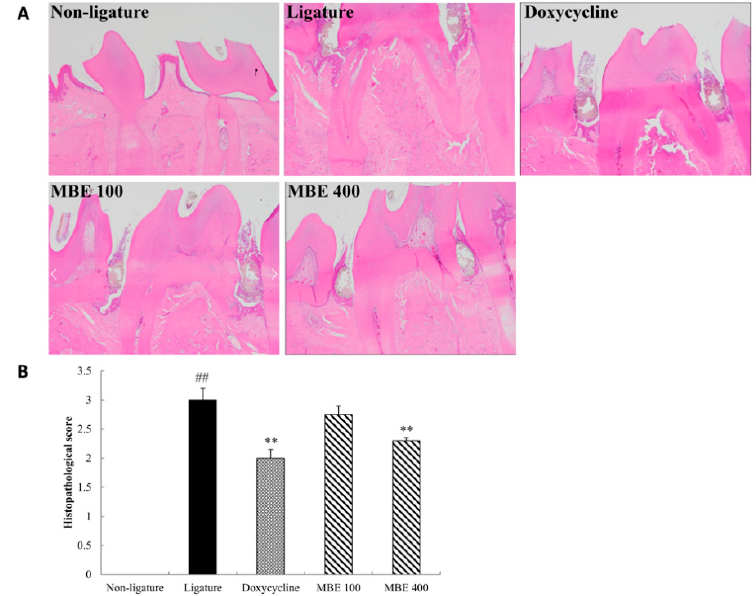
Figure 3. E ff ects of MBE on histological observation of inflammation and bone loss status in periodontitis rats. ( A ) Mandible tissues including molars were stained with hematoxylin-eosin and ( B )